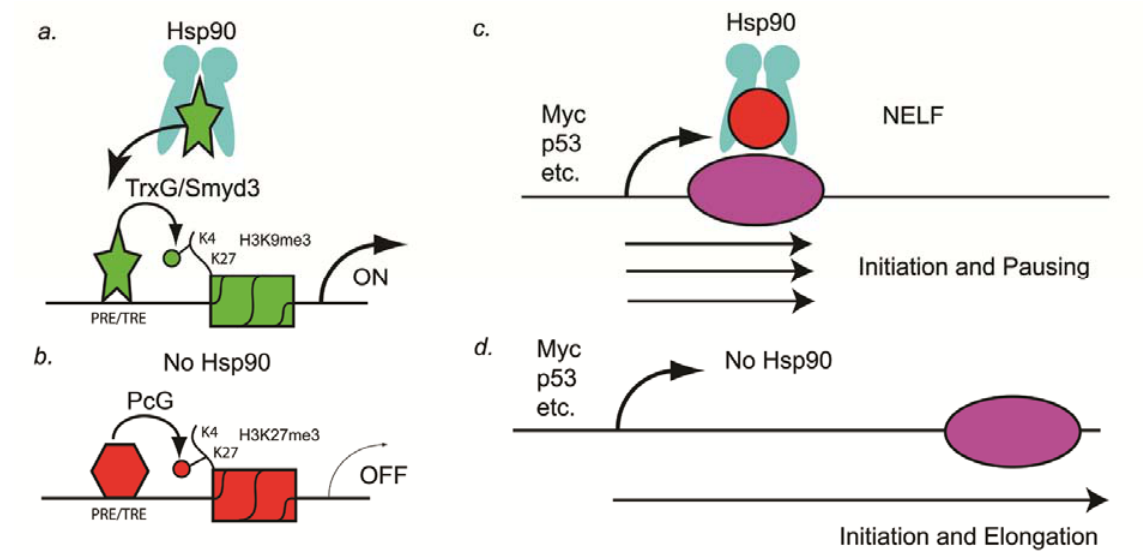
Figure 1. Hsp90 as a genetic and epigenetic capacitor for phenotypic variation. ( A ) In a non-stressed cell, Hsp90 binds to the H3K4 histone methyltransferase (Trx or Smyd3) and activates the enzymatic activity. Chromatin of PRE/TREs carrying this active histone mark is open for transcriptional activation; ( B ) In a stressed cell, Hsp90 is inactive and Trx is not activated. Consequently, PRE/TREs are occupied by PcG complex proteins, one of which is a H3K27 histone methyltransferase (PcG). Chromatin thus modified by this inactive histone mark leads to transcriptional repression; ( C ) In the presence of Hsp90, transcription pauses at as many as 30% of the genes, including the oncogene Myc and the tumor suppressor gene p53. Pausing is mediated by NELF (red circle), which is a target of Hsp90; ( D ) In the absence of Hsp90, NELF no longer induces pausing and transcriptional elongation occurs. Elongation of tumor suppressor genes such as p53 in cancer cells can lead to stasis or apoptosis, especially in combination with other anti-cancer